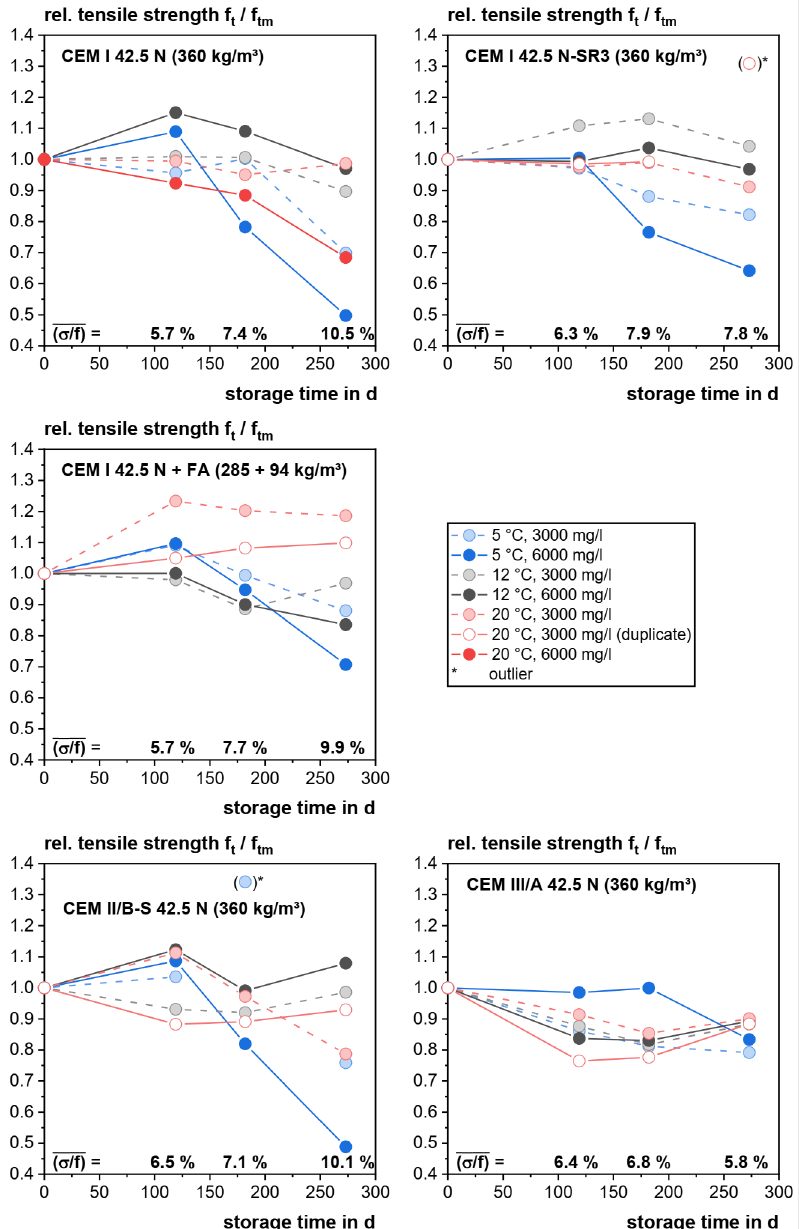
Figure 8. Relative tensile strength (ref.: maturity function) of concrete with w/c eq = 0.50 after storage in Na 2 SO 4